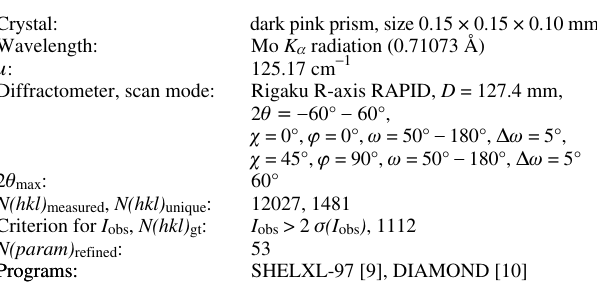
Table 1. Data collection and handling.